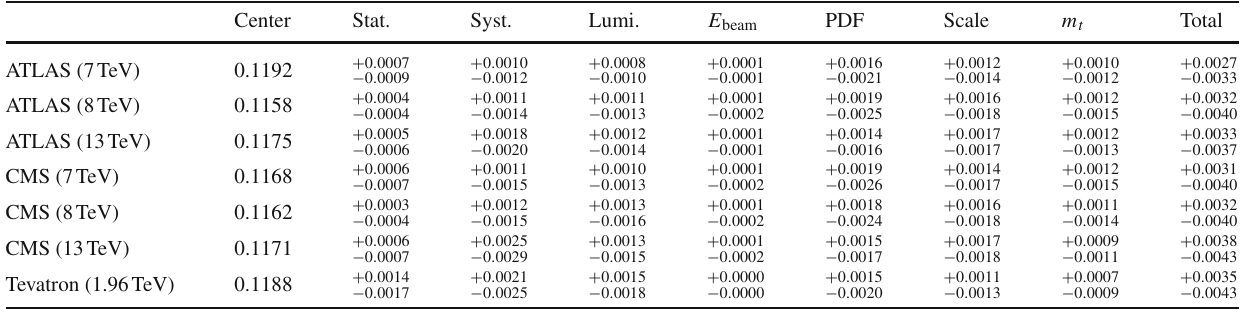
Table 6 As in Table. 4, but now using NNLO + NNLL cross sections with the CT14nnlo series of